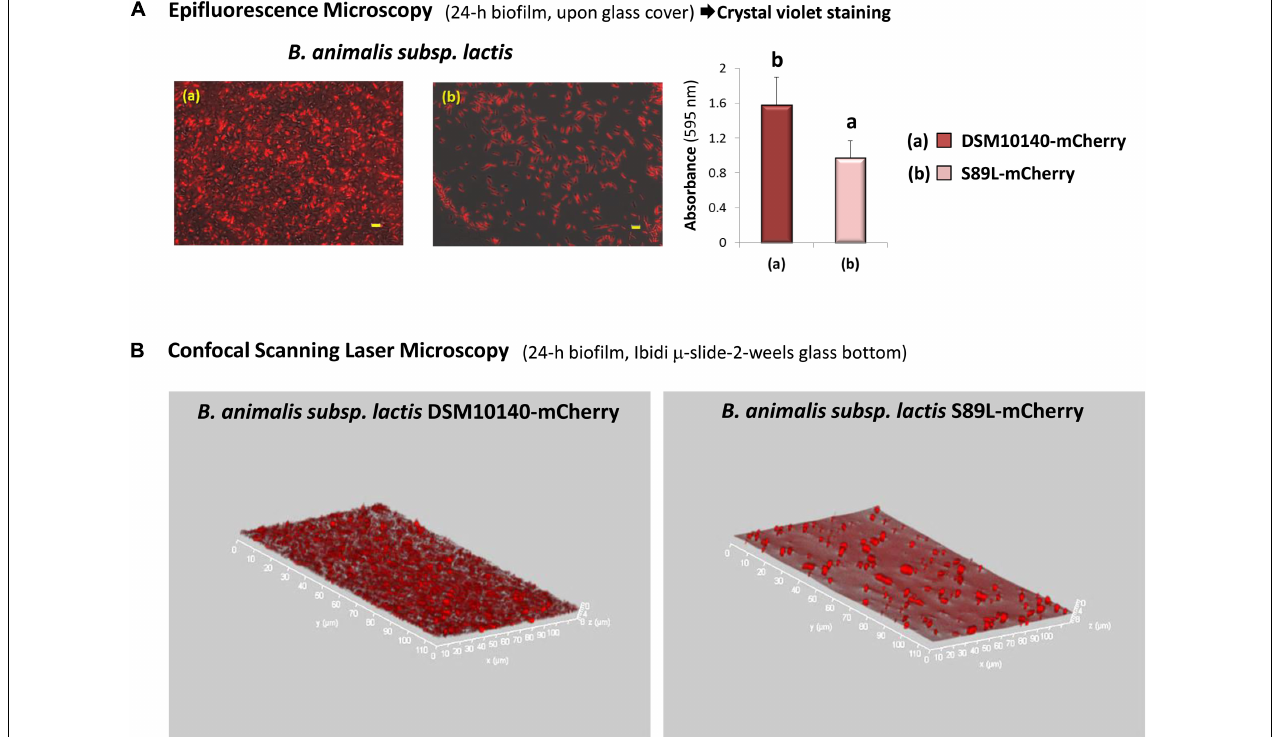
FIGURE 6 | Detection of fluorescence-labeled bifidobacterial DSM10140-mCherry and S89L-mCherry strains upon glass covers using the epifluorescence microscope (bar 5 µ m) and crystal violet quantification of the biofilms formed upon the glass covers; bars that do not share a common letter are significantly ( p < 0.05) different (A) . Rotated 3D-images obtained from the Z- projection (thickness about 2–4 µ m) showing the biofilm formed by B. animalis subsp. lactis DSM10140-mCherry upon glass µ -slides and the absence of biofilm by strain S89L-mCherry (B)